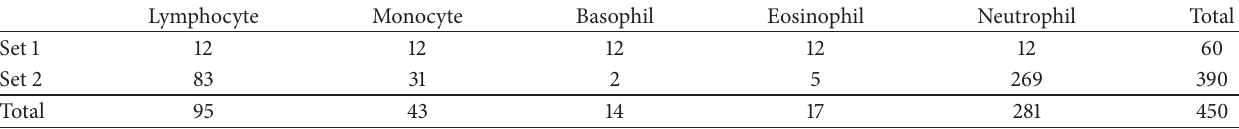
Table 1: The number of cell images for each kind of white cells.